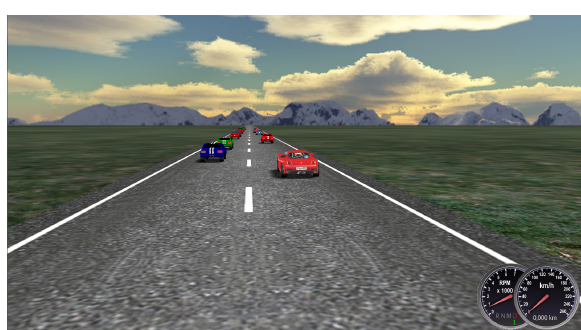
Figure 1. OpenDS simulator view, highway